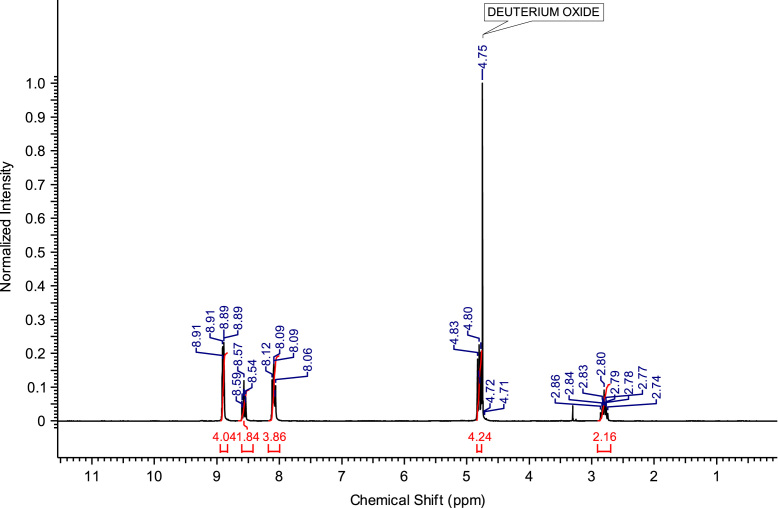
1H NMR spectra of C3(Pyr)2Br2.